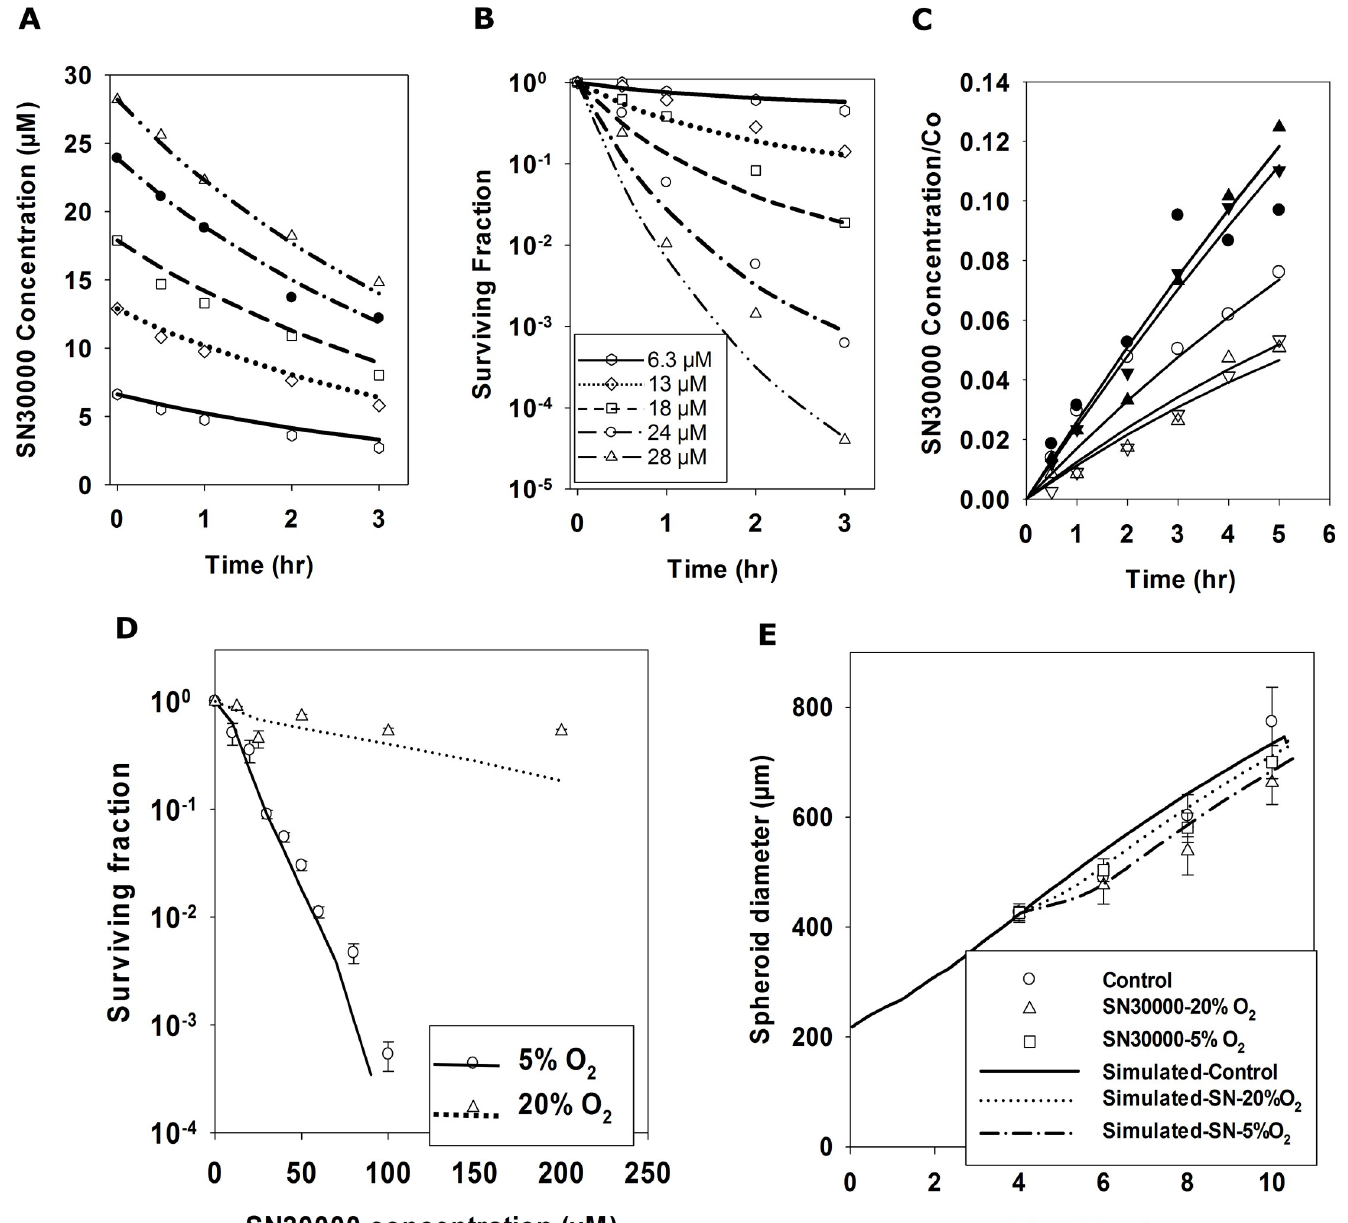
Fig 6. Development of a spatially resolved PK/PD model for SN30000 and testing by SABM simulation of spheroid response to SN30000 exposure. Cellular bioreductive metabolism of SN30000 ( A ) and clonogenic cell killing ( B ) was measured by serial sampling of stirred HCT116 cell suspensions (2 × 10 6 cells/mL) under anoxia (0% oxygen gas mixture). The rate constants for SN30000 metabolism ( k met0 ) and cell killing ( K c ) were estimated by fitting the data in panel A and panel B simultaneously using the MABM assuming the medium was fully stirred. Lines represent MABM predictions based on the parameters which minimize the overall error sum of squares (Table 1). ( C ) Diffusion parameters for SN30000 were estimated from HCT116 MCL transport studies illustrated for a single experiment. Lines are model fits using the reaction-diffusion program described in methods with fitted parameters for each MCL: D SN30000 estimated from MCL transport under hyperoxia (95% O 2 , filled symbols in panel C ) assuming no metabolic consumption (confirmed by no production of SN30000-1-oxide); k diffusion under anoxia (open symbols in panel C ) by fixing D SN30000 at its mean value (Table 1) determined in hyperoxic experiments. ( D ) To quantitate cytotoxicity, spheroids seeded with 1000 cells were exposed on day 4 to a range of SN30000 concentrations for 2 hr under 20% or 5% O 2 and clonogenic cell survival was measured (points in Panel D ) and compared to predictions of SABM incorporating the optimized reaction-diffusion and cell kill parameters estimated from monolayer and MCL experiments from Table 1 (lines in Panel D ). ( E ) To measure spheroid growth delay induced by SN30000, spheroids were exposed to 25 μ M SN30000 under 5% O 2 or to 100 μ M SN30000 under 20% O 2 for 2 hr and spheroid diameters were monitored (points in Panel E ) and compared to the SABM predictions (lines in Panel E ) using parameters from Table 1. Values are mean ± SD (n = 16